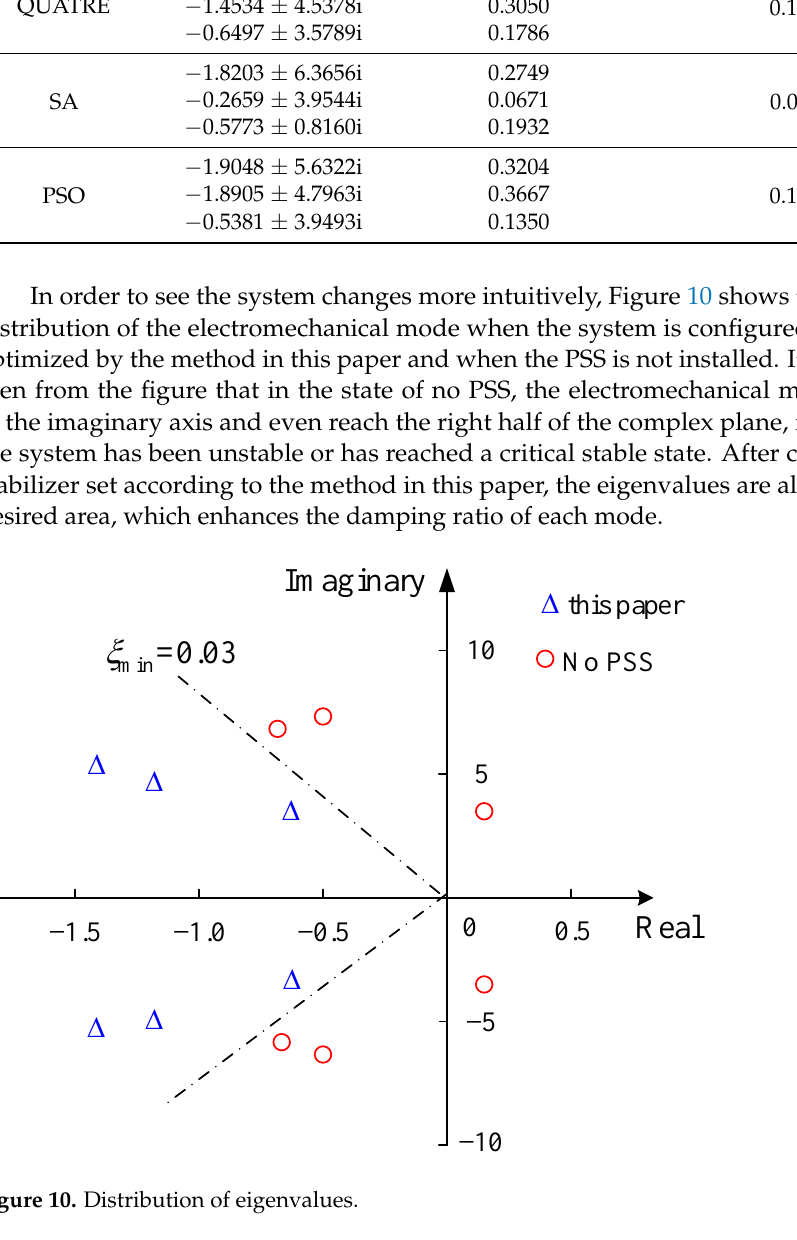
Figure 11. Active power output of tie-line.